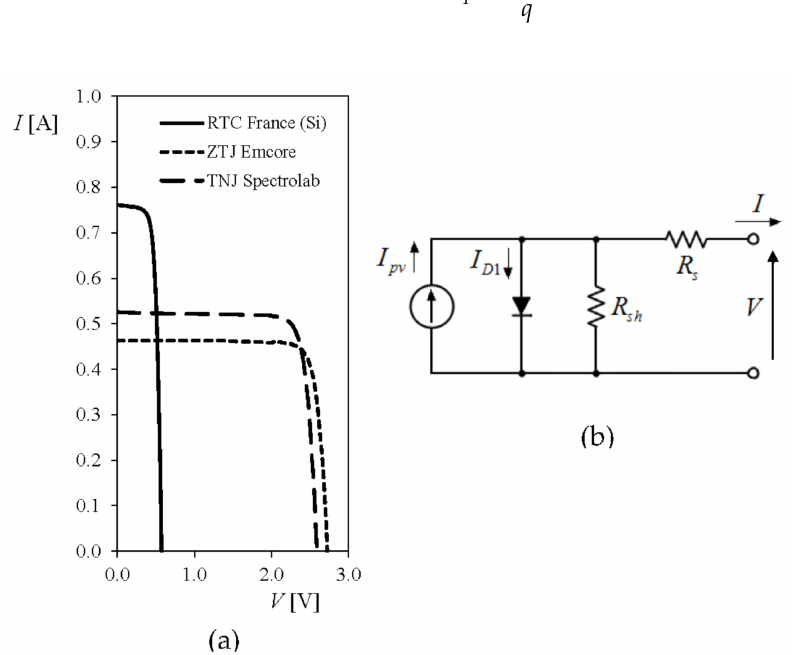
Figure 1. ( a ) I-V curves for three different solar cells; ( b ) 1-D/2-R equivalent circuit model for analyzing the behavior of a solar